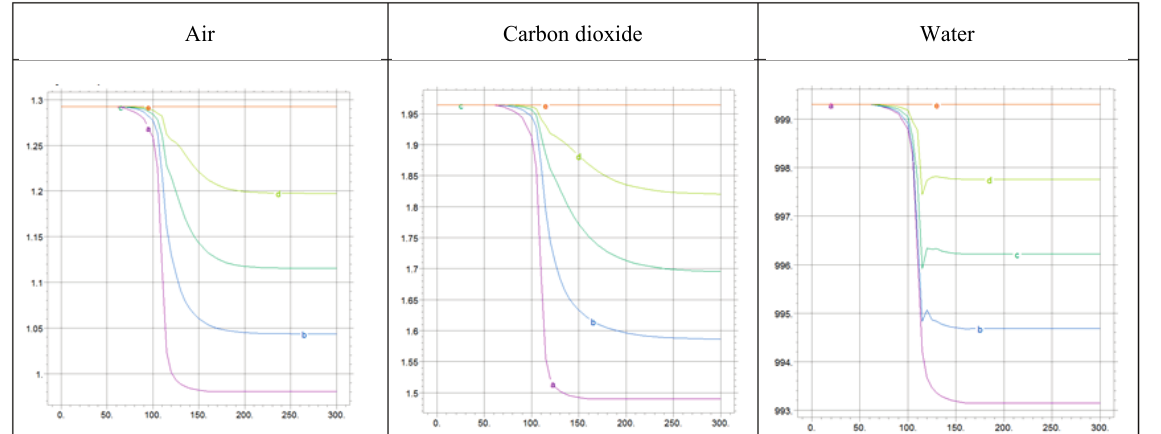
Table 7. Time course of fluid